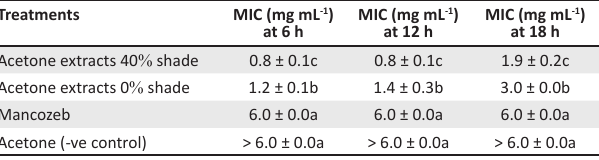
TABLE 3: Minimum inhibitory concentration (Mean ± SE) on Fusarium oxysporum by acetone extracts obtained from aerial parts of Allium porrum grown under 40 % shading and 0 % shading conditions at 12 weeks post-treatment. Treatments MIC (mg mL -1 ) at 6 h